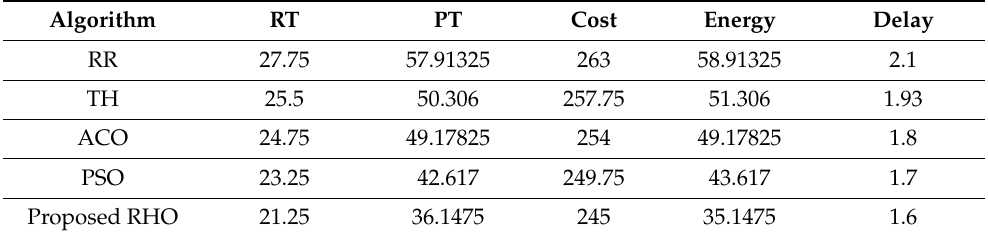
Table 6. Comparison of Various QoS parameters obtained after